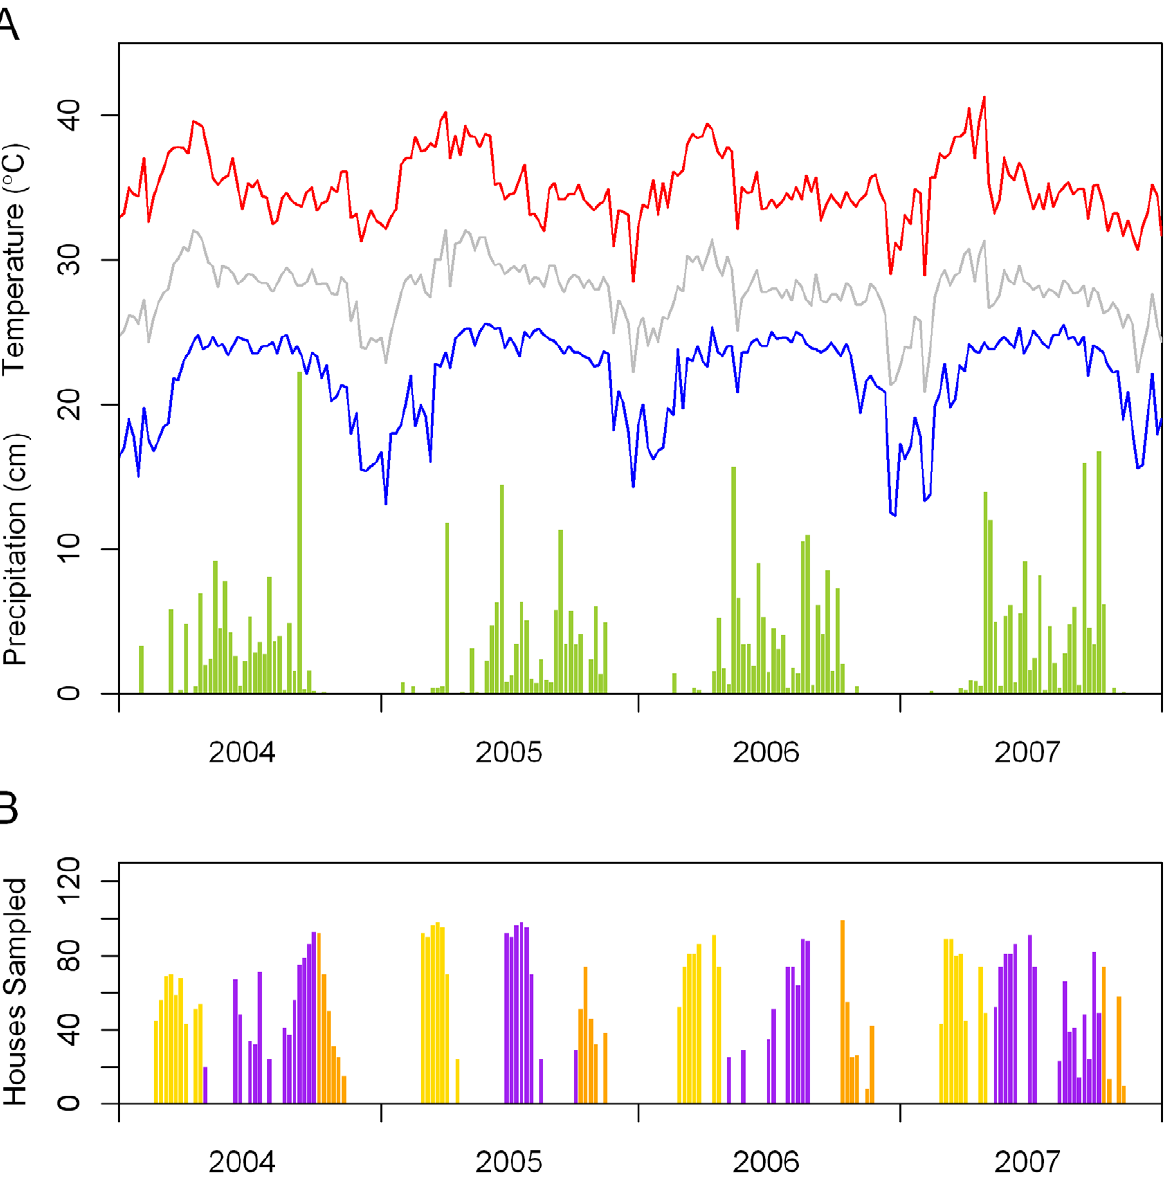
Figure 2. Meteorology and timing of samples. The lines in part A show the weekly maximum, minimum, and mean temperatures for the study area. The height of the bars indicates the weekly precipitation totals. Part B shows the number of households sampled per week during the study period. The yellow bars represent the early season samples, and the orange bars represent the late season samples. The purple bars indicate samples during the transmission season, primarily cluster surveys.